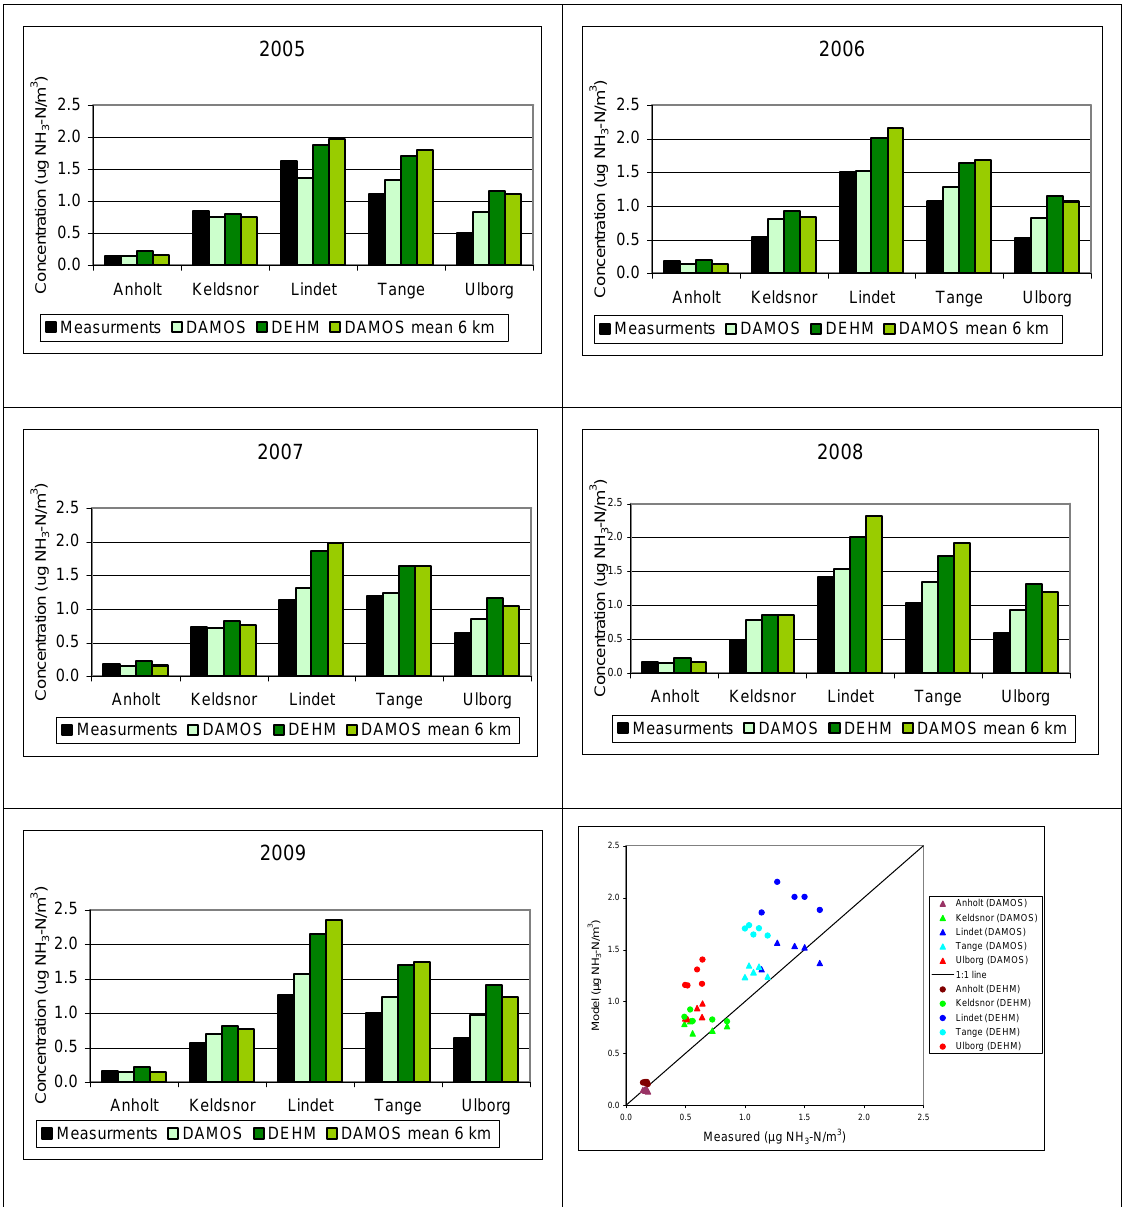
Figure 4. Measured and modelled yearly NH 3 concentrations at the five main monitoring sites as a column diagram for each of the years 2005-2009 and collected in a scatter diagram.